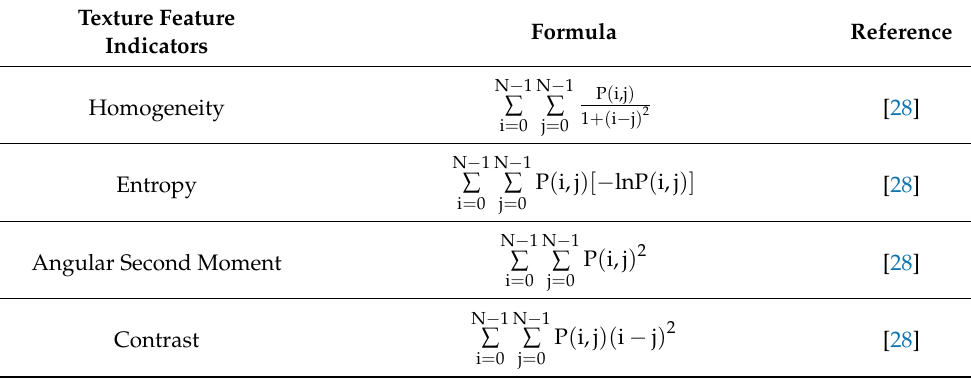
Table 2. Texture feature indicators of object-oriented